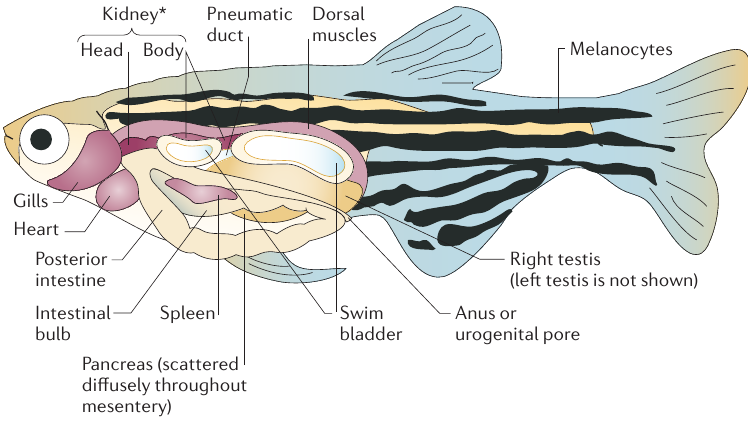
Figure 1 | Zebrafish anatomy. An adult zebrafish is shown with the anatomical Figure 3. The anatomy of a typical adult zebrafish. Reproduced with permission from [17], Copyright structures labelled. Zebrafish share most of their organs with mammalian counterparts, including the brain, heart, liver, spleen, pancreas, gallbladder, intestines, kidney, testis Nature Publishing Group, and ovaries. *The kidney is also the site of haematopoiesis in zebrafish.